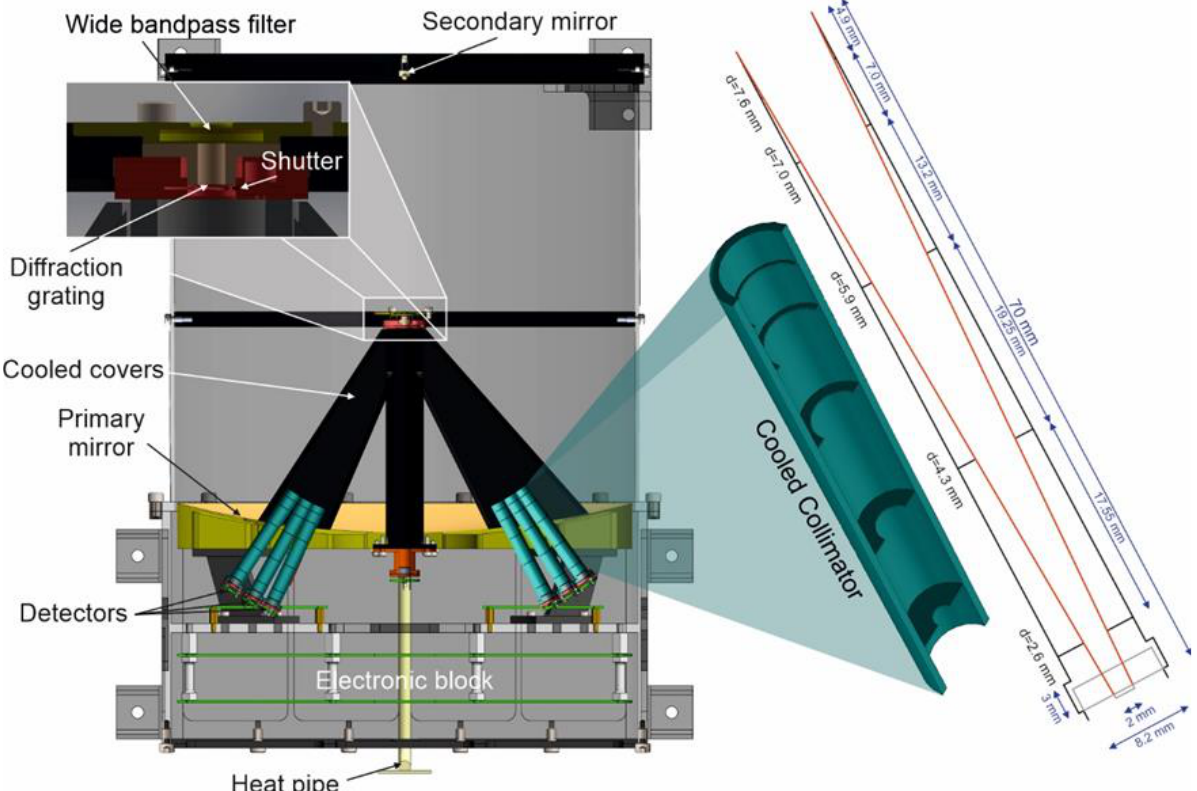
Figure 9. Simplified cross section of the MIRORES instrument. The size of the instrument is 42 × 32 × 32 cm. The six main detectors are placed behind the six turquoise collimators, the optical design of which is depicted on the left. The zoom on the right shows the position of the shutter behind the diffraction grating. The wide bandpass filter transmits radiation in the 21–30 µ m range. Measurements in only six bands allow the instrument dimensions to be 42 × 32 × 32 cm and the instrument mass to be <10 kg (Figures 8 and 9). The instrument optics are based on two mirrors (primary and secondary) set up in a typical Cassegrain system. The primary mirror with a diameter of 300 mm reflects the radiation into the smaller second- ary mirror with a diameter of 4.1 mm located at a distance of 300 mm. Then, all radiation reflected from the secondary mirror is di rected to the wide bandpass filter (20−33 μm) and a diffraction grating. Here, the broadband beam is split into six quasi-monochromatic beams, which are refracted and fall into the set of six pyroelectric detectors (three for tar- get minerals, two for reference, and one for the clinopyroxene interference). The detectors are mounted on a copper plate to facilitate heat dissipation. Heat dissipation is reinforced by a temperature stabilization system. The radiation stream transmitted by the device’s optical system is digitized by a front-end electronics (FEE) system and sent to an onboard computer. The key components of the instrument, the primary and secondary mirrors, will be connected to the satellite through heat pipes. Assuming that the mirrors are shielded from direct solar radiation by the satellite body, they receive only from 22 W (Mars blackbody radiation) to 32 W (blackbody radiation + reflected radiation from the Sun), so the heat pipes need to expel on average 27 W to maintain a constant temperature. In the assumed model, Mars has a temperature of 193 K at night, the solar flux is 715 W/m 2 , the satellite temperature is 273 K, the space temperature is 4 K, and the electronic power dissipates up to 10 W. 5. Optical System The optical system is composed of a primary mirror, a secondary mirror, a filter, a diffraction grating, and collimators for each detector (Figure 9). The primary mirror has a diameter of 300 mm and is made of alumina. The secondary mirror is formed by a gold- covered steel sphere; which is a bearing ball with a diameter of 4.1 mm easily available on the market, manufactured, for example, by FŁT Polska Sp. Z.o.o . The distance between the primary and secondary mirrors is 300 mm (Figure 10). The effective focal length of the telescope is 30.3 m, the detector window diameter is 2 mm, and the assumed satellite alti- tude is 250 km. The field of view in a static position can thus be calculated as 0.002 m